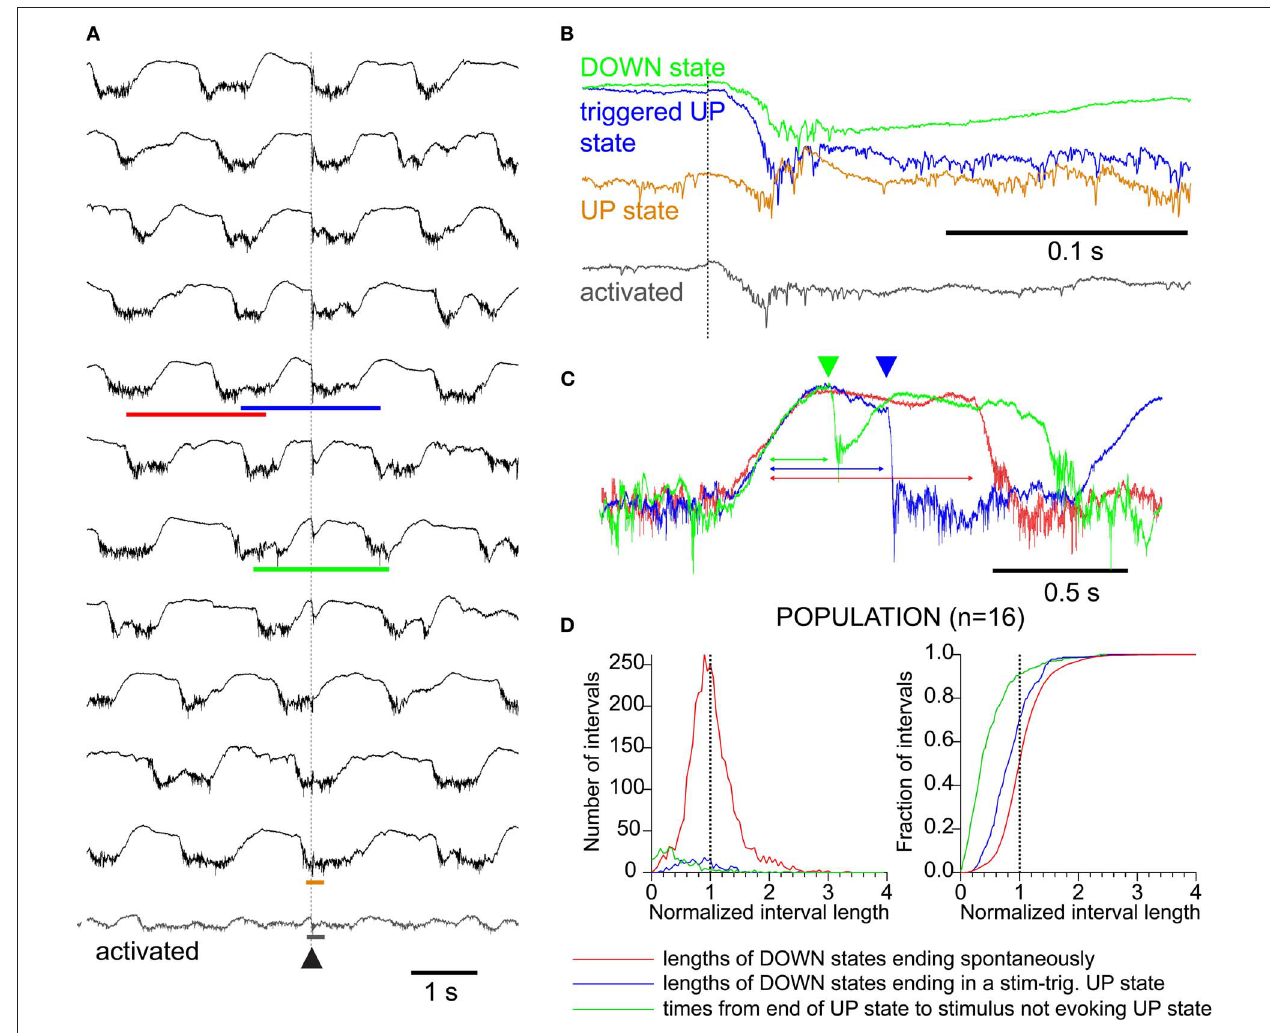
traces, respectively. The red trace shows a cycle without a stimulus for comparison (see red bar in A ). (D) Distributions (left) and cumulative distributions (right) of time measurements showing effects of state changes and responses on each other. RED: lengths of down-states which end spontaneously (compare to red trace in 1 C ). BLUE: lengths of down-states which end in a stimulus-associated up-state transition (compare to blue trace in 1 C ). GREEN: interval between the start of a down-state and a stimulus that did not trigger an up-state transition. Down-state shortening due to stimulus: green is shorter than blue (K–S test, p < 0 . 01); Up-state refractory period: blue is shorter than red (K–S test, p < 0 .